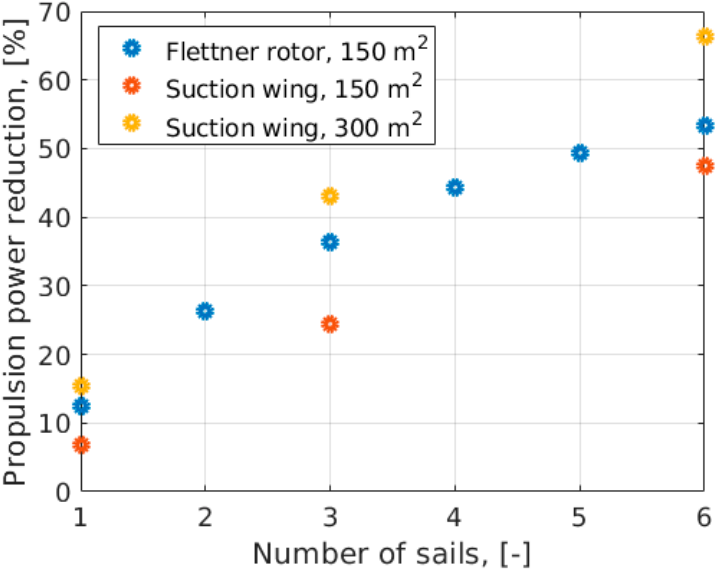
Figure 9. Achievable propeller thrust savings with different numbers of installed Flettner rotors and Suction wings.